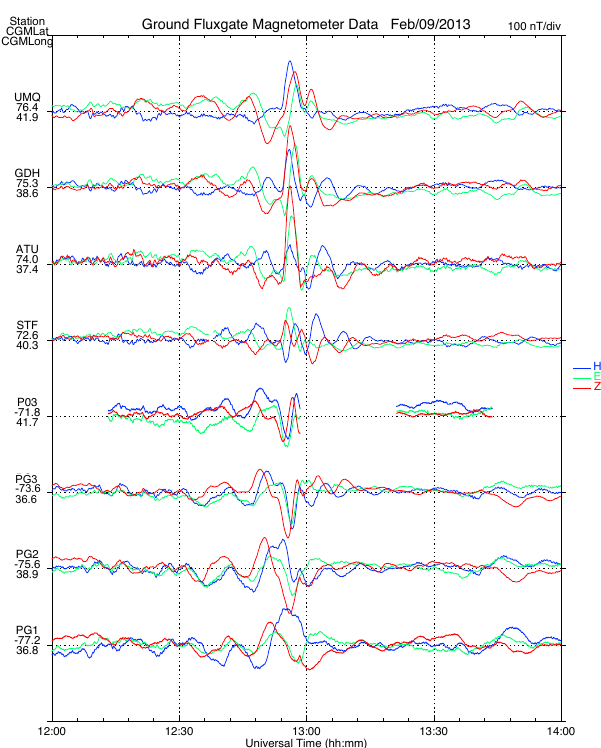
Figure 15. Geomagnetic impulse events observed by the fluxgate magnetometers at four station pairs in magnetically conjugate hemi- spheres (UMQ-PG1, GDH-PG2, ATU-PG3 and STF-P03) starting approximately at 12:45UT on 9 February 2013.